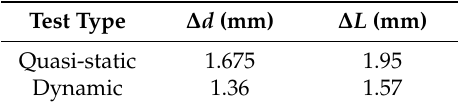
Table 1. Quasi-static and dynamic measurements.